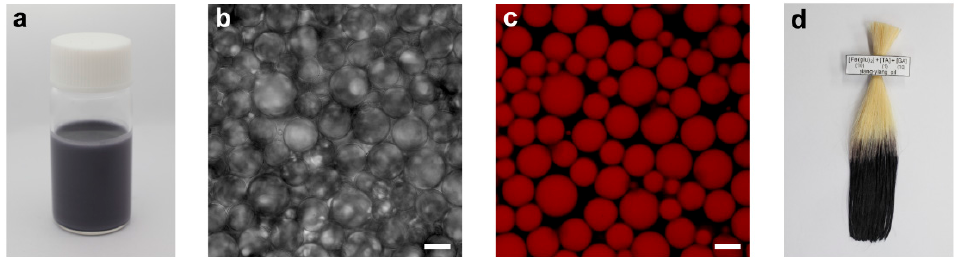
Figure 2. ( a – c ) Characterizations of the surfactant-free emulsions with the ylang-ylang oil-based emulsion as a representative. ( a ) Optical photograph of the emulsion-containing vial. ( b ) Optical and ( c ) CLSM images of the emulsion. Scale bar: 10 µ m. ( d ) Optical photograph of the hair sample after dyeing with the ylang-ylang oil-based emulsion. The characterization data for the other emulsions are presented in the Supplementary Materials.